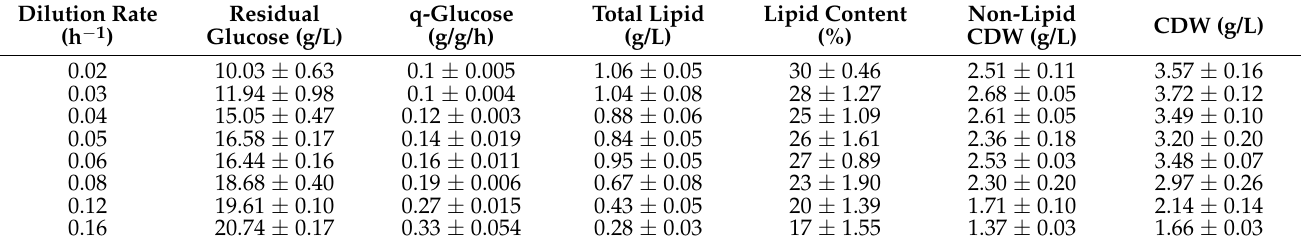
Table 1. Results of the chemostat cultivation of Y. lipolytica OKYL049 at different dilution rates under nitrogen